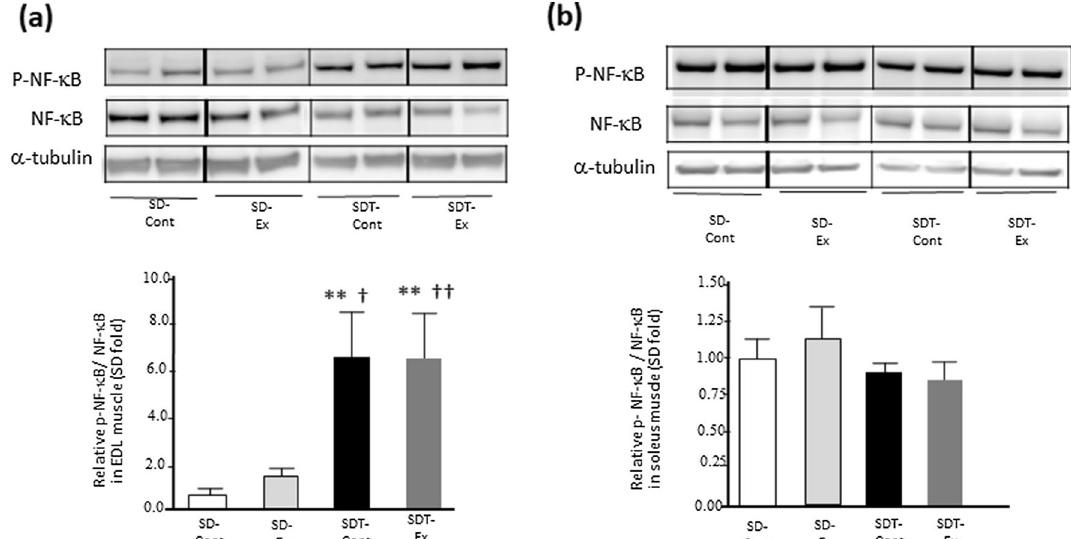
Fig. 4 Protein expression of phosphorylated Nuclear Factor‑κB (NF‑κB) in the extensor digitorum longus (EDL) and soleus muscles. Protein expression of phosphorylated Nuclear Factor‑κB (NF‑κB) ( a : EDL, b : soleus) in the EDL and soleus muscles as determined by western blot analysis. Entire images of western blotting are shown in online Additional file 1: Fig. S5. Values are presented as mean standard error of the mean. SD‑Cont ± group, n 5; SD‑Ex group, n 5; SDT‑Cont group, n 6; and SDT‑Ex group, n 6. * P < 0.05 and ** P < 0.01 vs. the SD‑Cont group, † P < 0.05 and = = = = †† P < 0.01 vs. the SD‑Ex group, and § P < 0.05 and §§ P < 0.01 vs. the SDT‑Cont